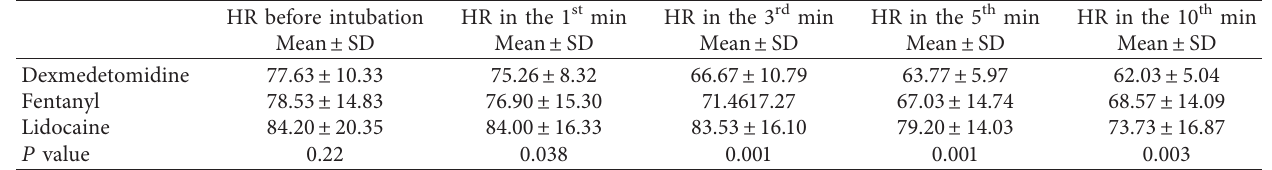
Table 2: Intergroup comparison of HR (meaningful level P < 0 . 05.